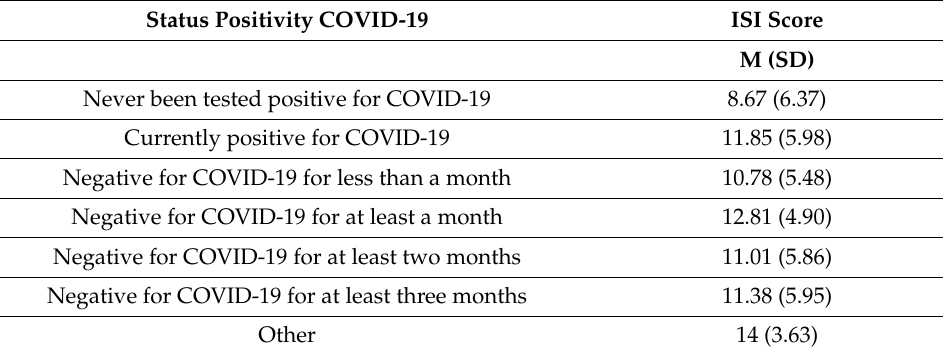
Table 3. Mean values (M) and standard deviation (SD) of the ISI scores stratified according to the different COVID-19 conditions.